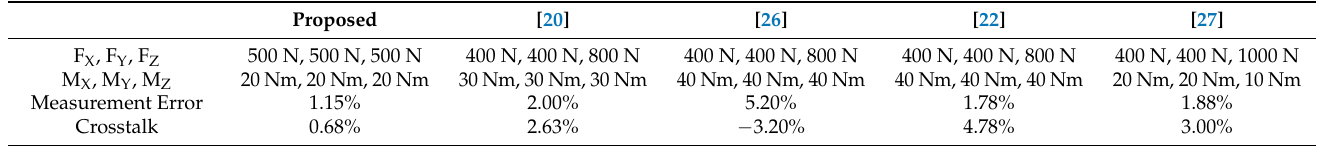
Table 12. The comparison on maximum measurement error and